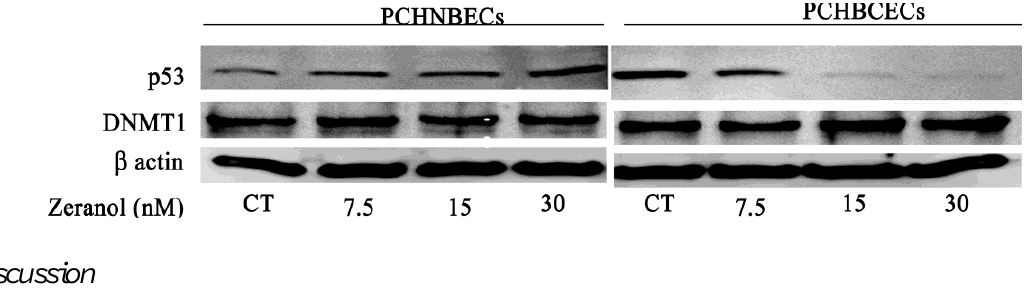
Figure 4. Zeranol regulates the expression of p53 and DNMT1 proteins in PCHNBECs and PCHBCECs. PCHNBECs and PCHBCECs were seeded in 10 cm culture dishes at a density of 1 × 10 6 cells/dish and then treated with 7.5, 15, 30 nM Z or 0.1% DMSO as a vehicle control for 24 h. Proteins were extracted from each treatment group and Western blot analysis was conducted.  -actin was used to confirm equal loading of total proteins during